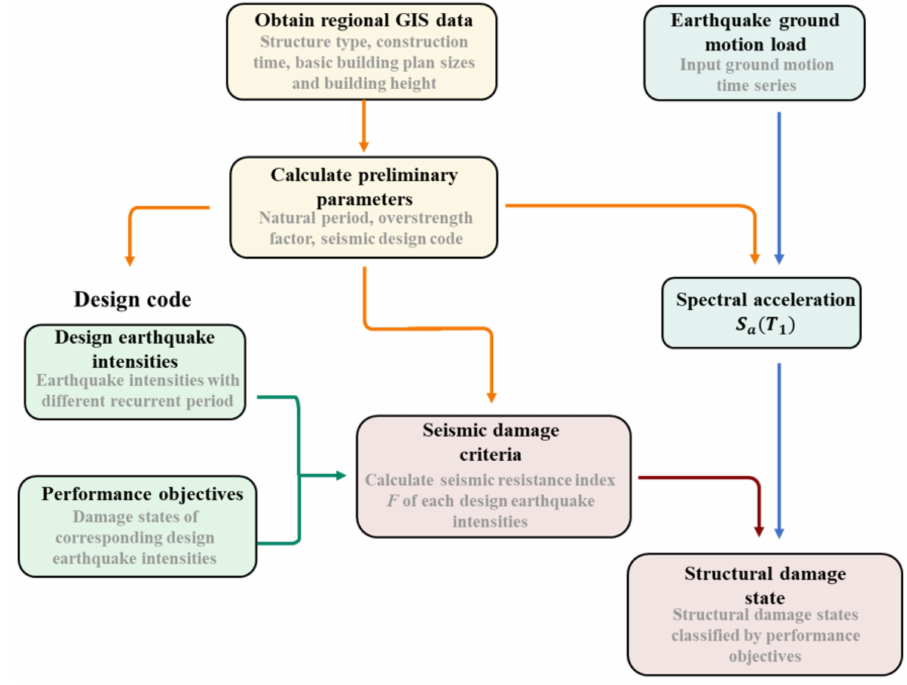
Figure 1. Flowchart of the design-strength-based seismic damage prediction method. Table 2. The design-strength-based method’s structural damage